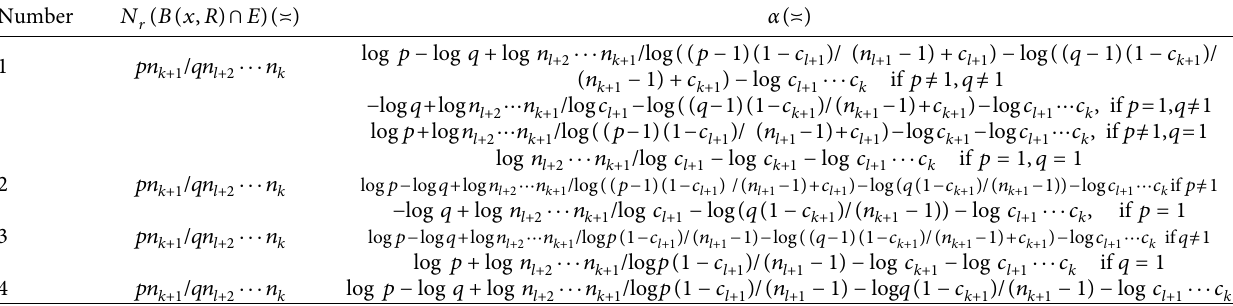
Table 4: The calculation of α